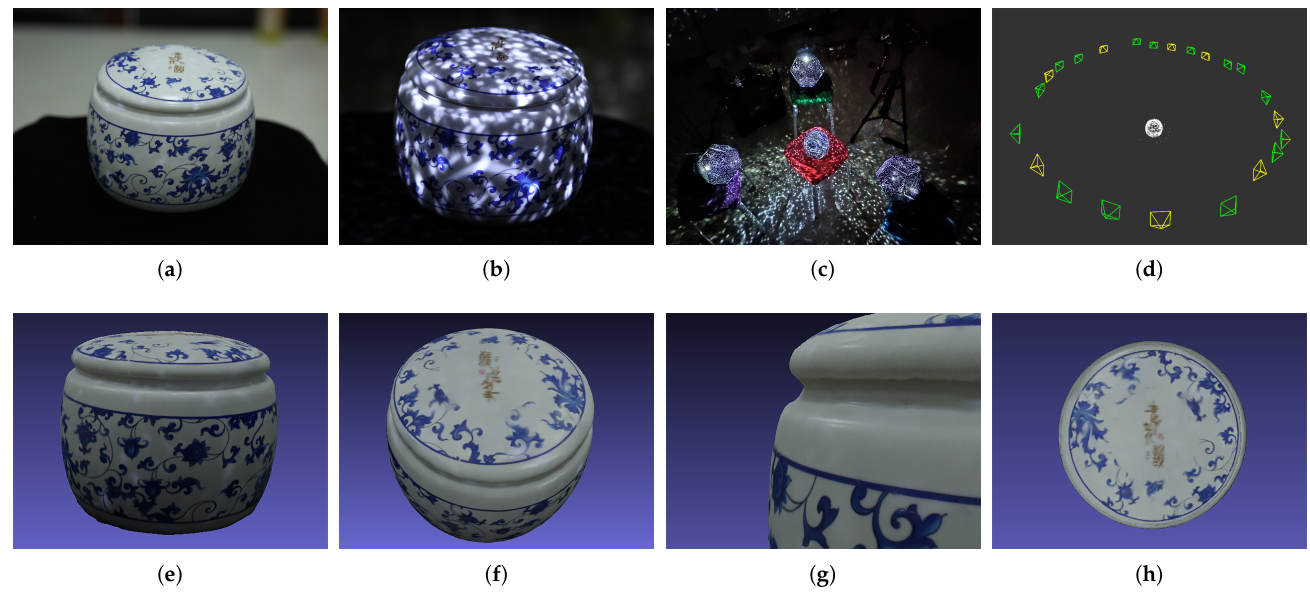
Figure 16. Reconstruction of a teapot. ( a ) A picture of the teapot used for 3D reconstruction (“dark” picture); ( b ) The corresponding picture used for real texture (“bright” picture); ( c ) Light sources and teapot with spark pattern; ( d ) Sparse reconstruction and the camera poses (we take both “dark” and “bright” pictures at the yellow poses ); ( e – h ) Different views of the reconstructed